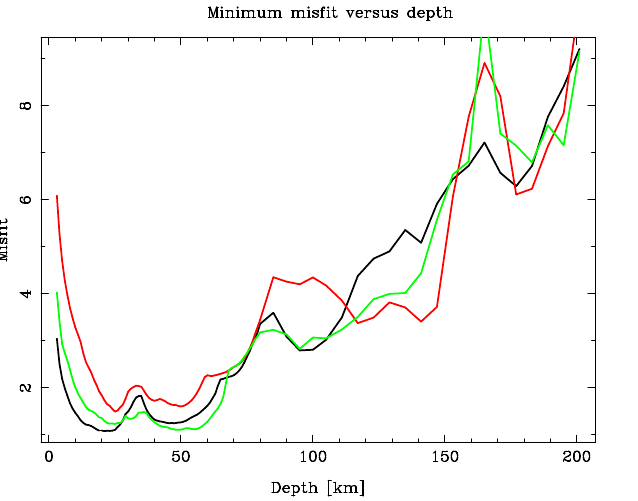
Figure 10. Best obtainable misfit as a function of source depth for the three locations by (black) Okal et al. (2009), (red) Comninakis and Papazachos (1986) and (green) Makropoulos et al. (1989).